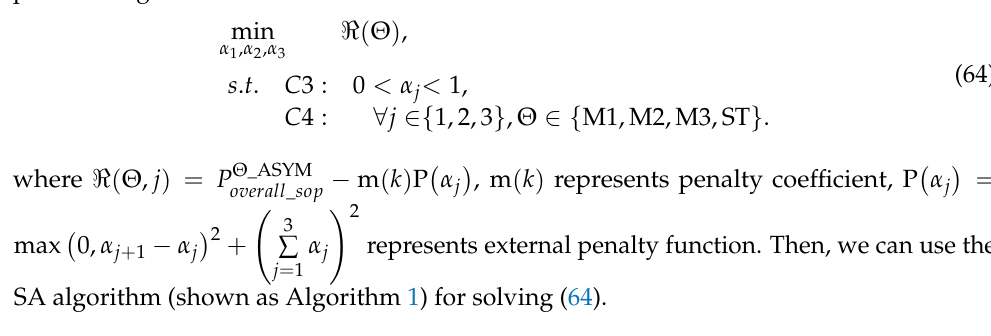
Algorithm 1 The SA Algorithm to solve